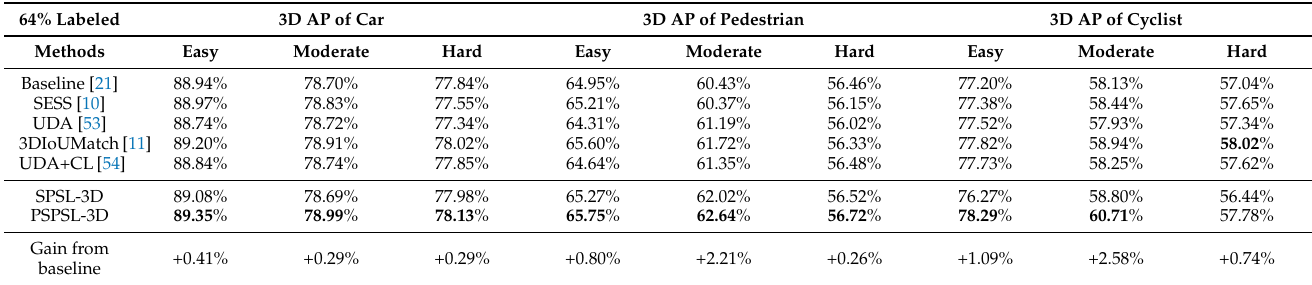
Table 5. 3D AP of current SSOD-3D methods in KITTI validation dataset at R anno = 64%.